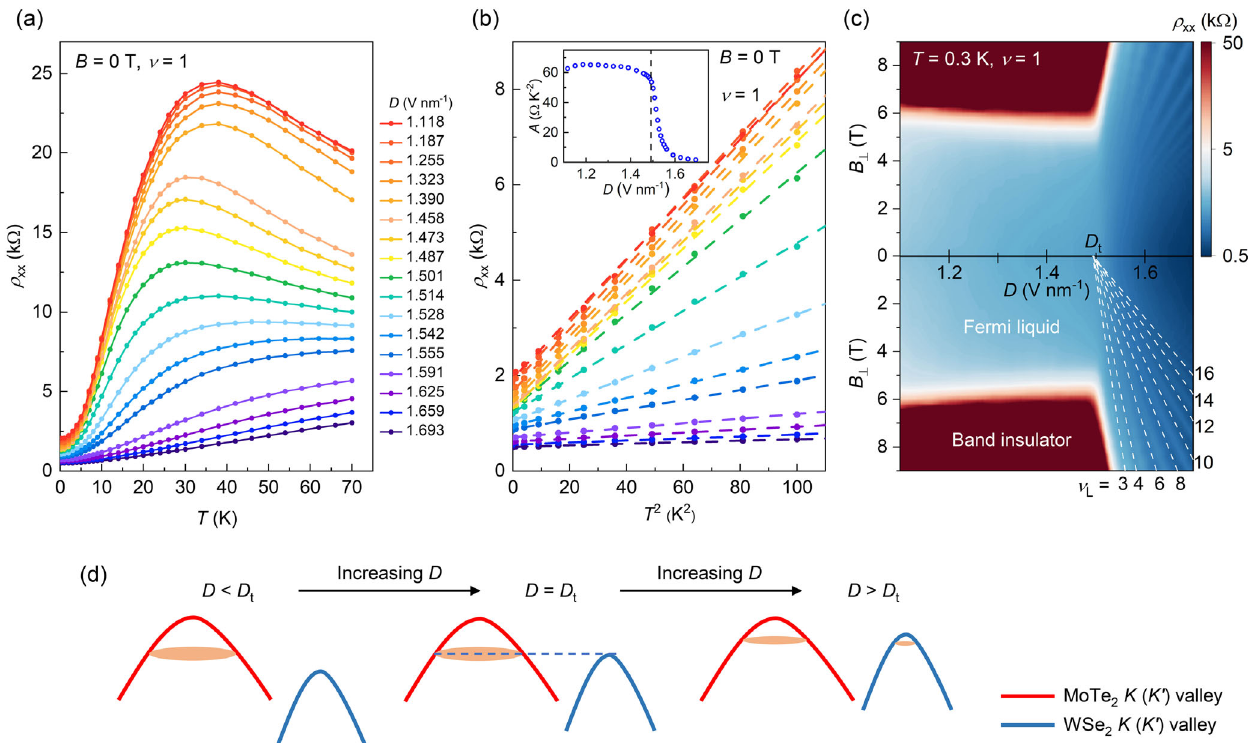
FIG. 2. Electric displacement field-driven Lifshitz transition. (a) Temperature dependences of ρ with varying displacement field D at xx ν ¼ 1 and B ¼ 0 T. (b) The same data as (a) (sharing the same color coding) with the x axis scaled in T 2 below about 10 K. The dashed lines are the corresponding linear fits. Inset: fitting parameter A as a function of D . The vertical dashed line indicates the inflection point at D ¼ D . (c) The upper diagram shows ρ as a function of out-of-plane magnetic field B ⊥ and D at ν ¼ 1 and T ¼ 0 . 3 K. The lower t xx diagram shows color-coded regions representing different states. The Landau fan (linear dashed lines) converges to D , with filling t factors ν labeled accordingly. (d) Schematics showing the Lifshitz transition and evolution of band alignments ( K valleys of MoTe 2 and L WSe 2 ) with increasing electric displacement field D . The K 0 valley is degenerate with the K valley at zero magnetic field and, hence, not drawn on this schematic. Various effects (such as moir´e band formation and interaction-induced mass renormalization) are neglected in this simple schematic. Above D , charges are transferred between the MoTe 2 and the WSe 2 t